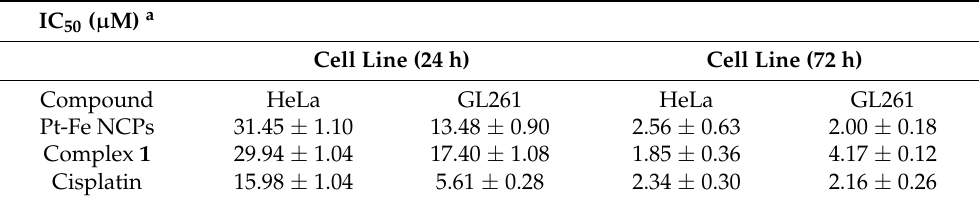
Table 1. Comparative study of IC 50 values for Pt(IV)-NCPs, Complex 1 , and cisplatin after 24 and 72 h of incubation.